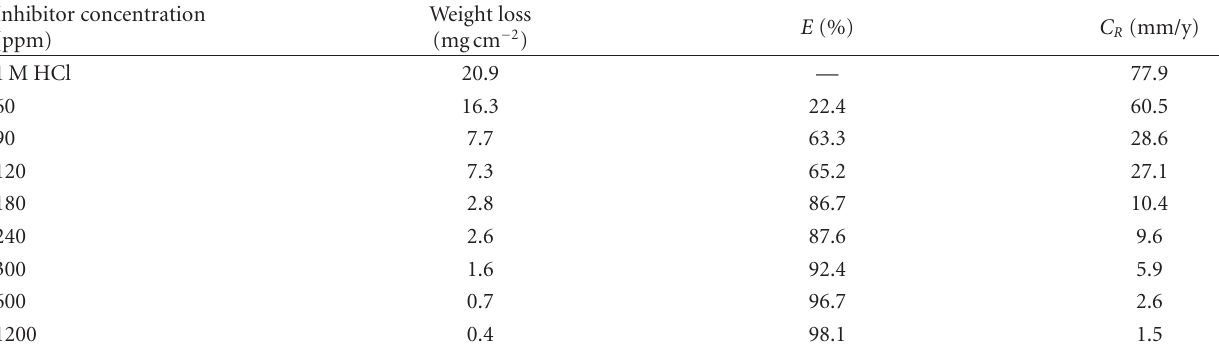
Table 1: Corrosion parameters for mild steel in aqueous solution of 1M HCl in presence and absence of di ff erent concentrations of Kalmegh ( Andrographis paniculata ) extract from weight loss measurements at 308 K for 3h.